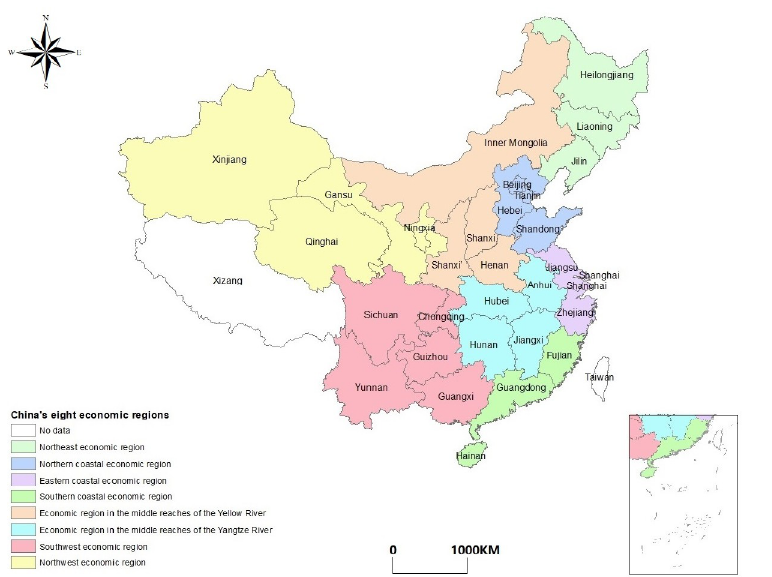
Table 1. The mean value of China’s eight economic regions’ relevant data from 2005 to 2017. Indicator Population density (Unit) (person/square kilometer)